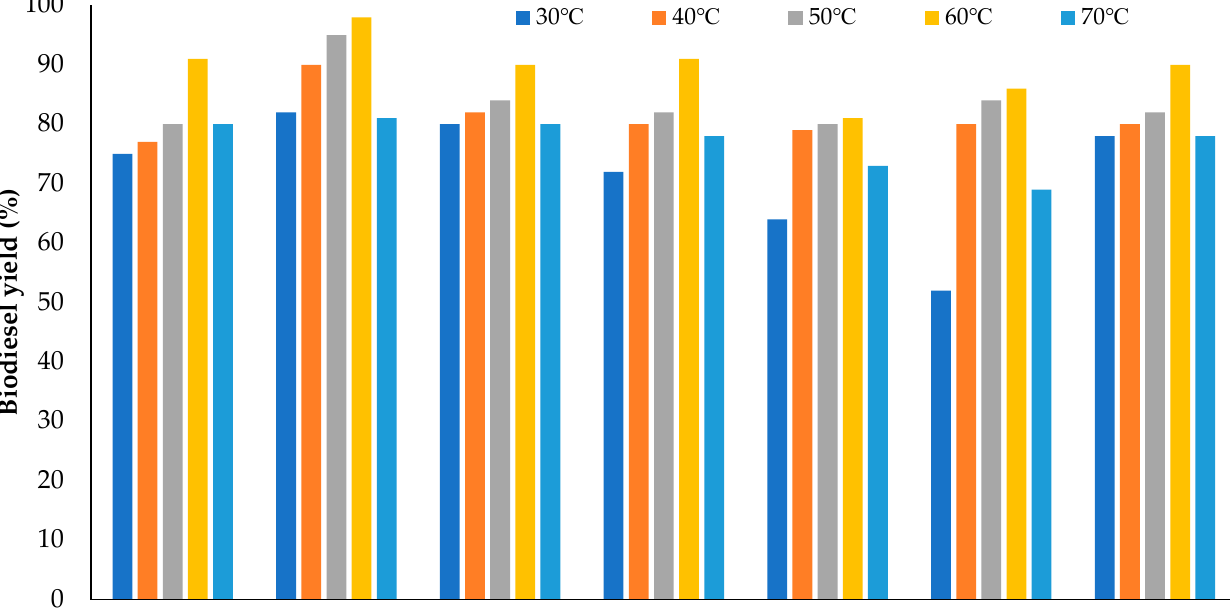
Figure 4. Effect of reaction temperature on biodiesel yield (catalysts concentration, 1 g; oil to methanol molar ratio, 1:10; time, 120 min).